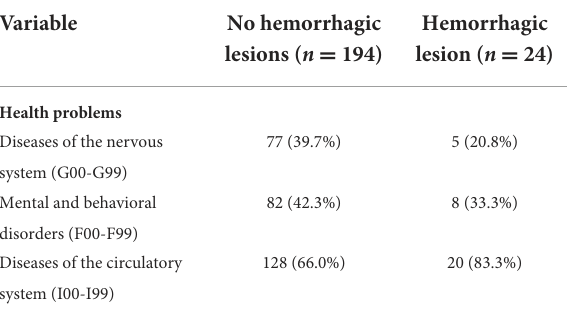
TABLE 2 Characteristics of the study patients stratified by the head CT